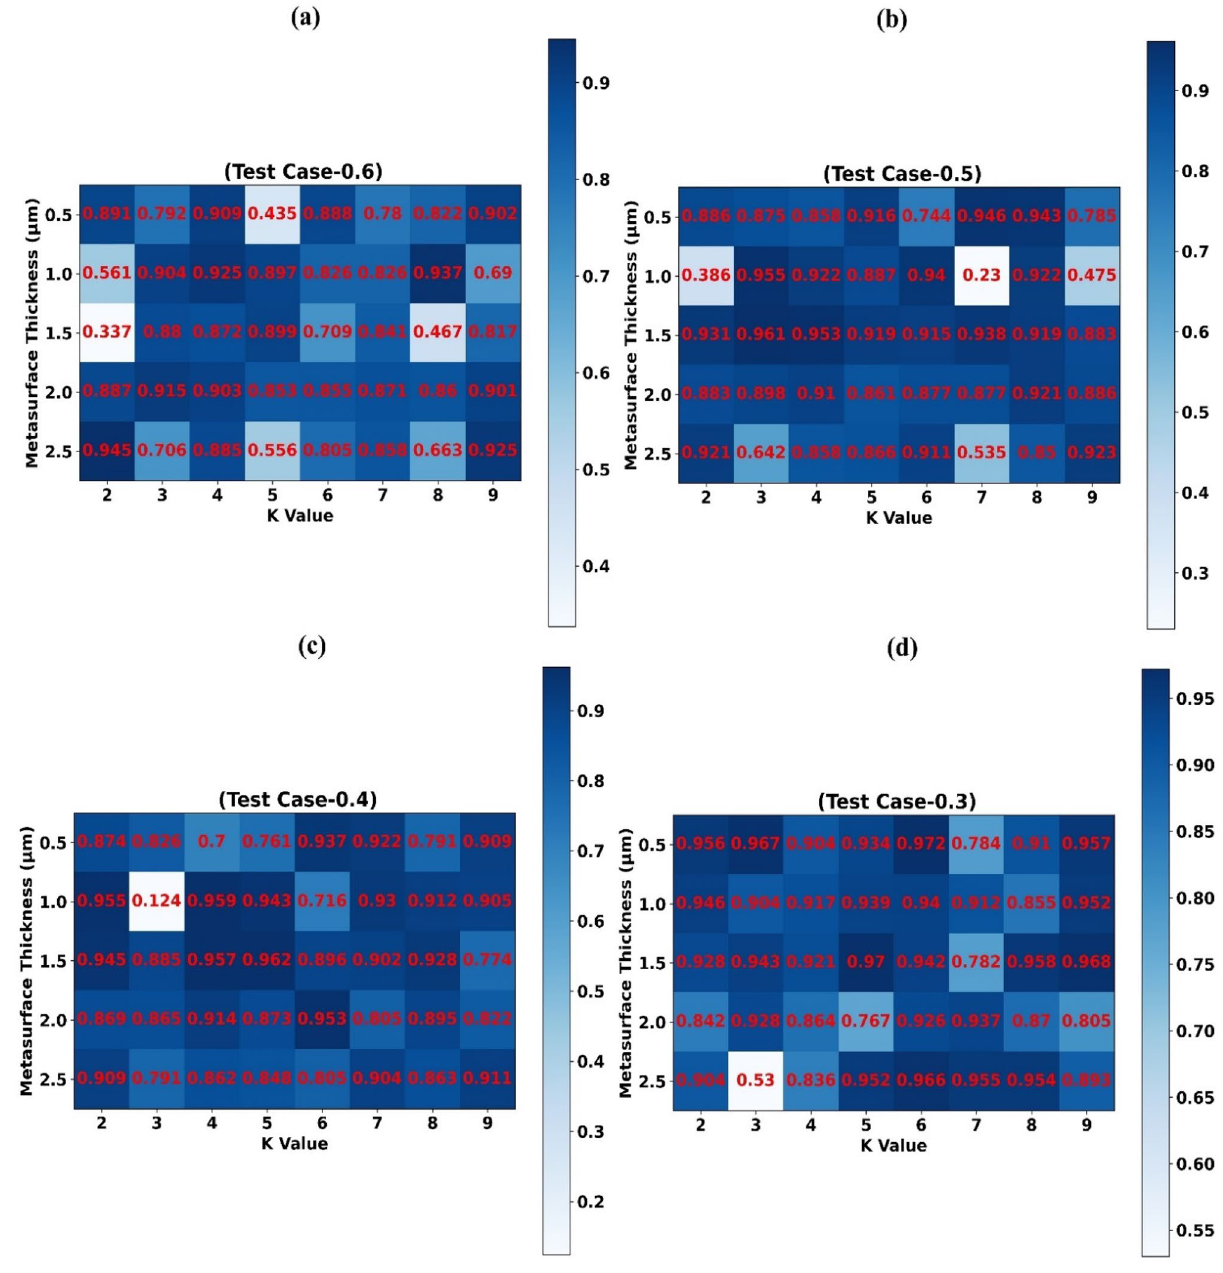
Figure 4. Prediction effectiveness (R2 Score) of traine Weighted KNN-regressor models for numerous values of Metasurface Thickness (µm) and ( a ) Test-0.6 ( b ) Test-0.5 ( c ) Test-0.4 ( d )